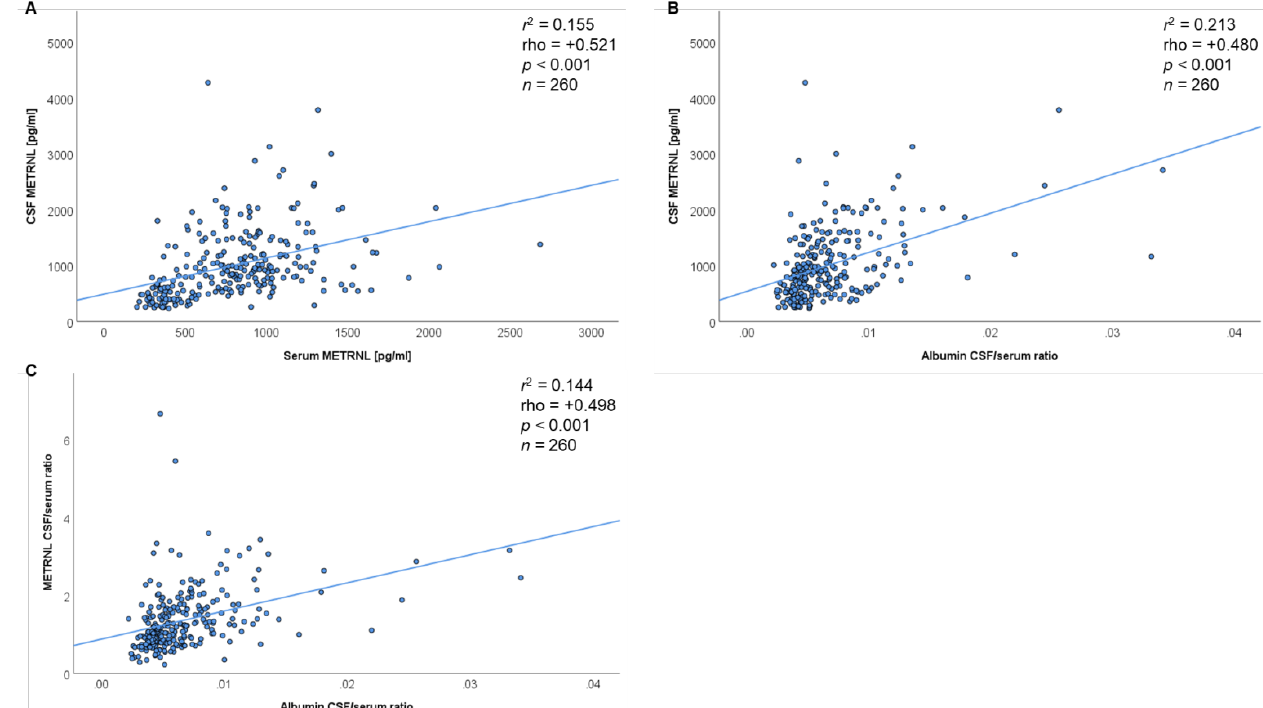
Figure 1. Scatterplot diagrams and Reibergrams indicating the migration of METRNL across the blood–brain barrier. ( A ) Positive correlation between METRNL serum and CSF concentrations. ( B ) Positive correlation between albumin CSF/serum ratios and CSF METRNL concentrations. ( C ) Positive correlation between albumin CSF/serum ratios and METRNL CSF/serum ratios (Reibergram). The Spearman rho test was used.